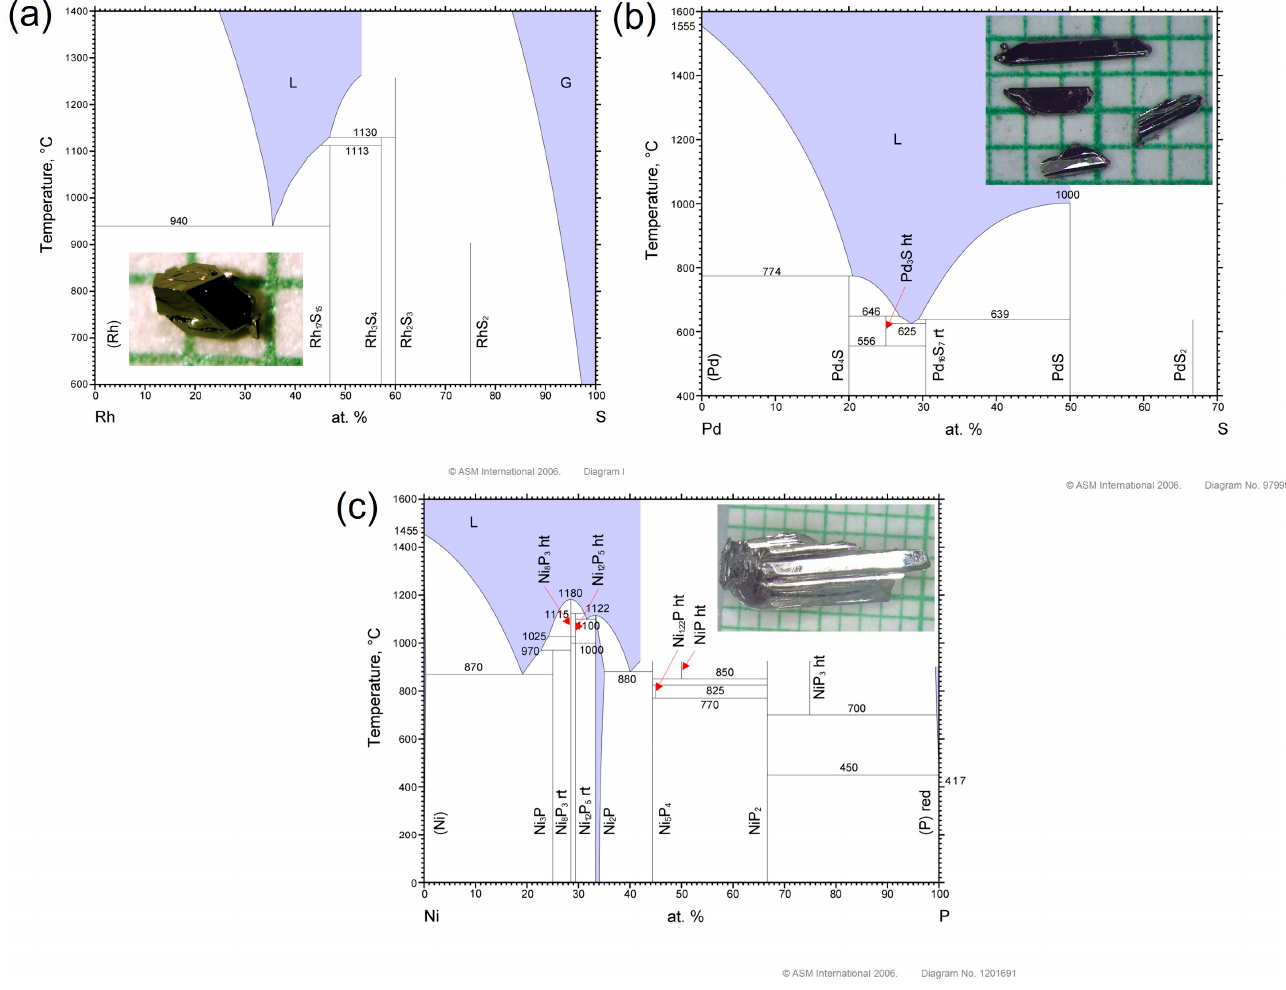
Figure 2. Binary phase diagrams for ( a ) Rh–S (ASM diagram #980012) [24], ( b ), Pd–S (ASM diagram #979991) [25] and ( c ) Ni–P (ASM diagram #1201691) [26]. The insets are pictures of ( a ) Rh 17 S 15 (miassite), ( b ) PdS (braggite) and ( c ) Ni 2 P (allabogdanite) on mm grid paper.